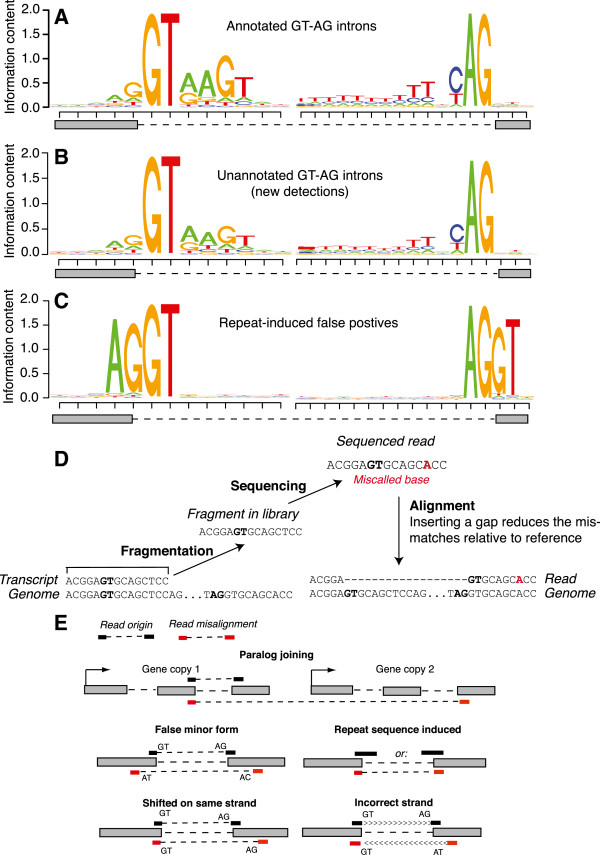
Sequence characteristics of false positive junctions. Sequence logos of exon and intron sequence bordering splice junctions in (A) annotated GT-AG introns, (B) unannotated GT-AG introns detected that pass filtering, and (C) repeat induced false positives. (D) Cartoon illustrating how false positives arise from repetitive sequence and sequencing error. A transcribed fragment from a region of repetitive sequence is incorporated into a library. A base calling error (in red) produces a read with an “A” instead of a “T” at the indicated position. This incorrect base call induces an incorrect gapped alignment that minimizes sequence mismatches. (E) Illustration of each false positive error type (Table 
2).